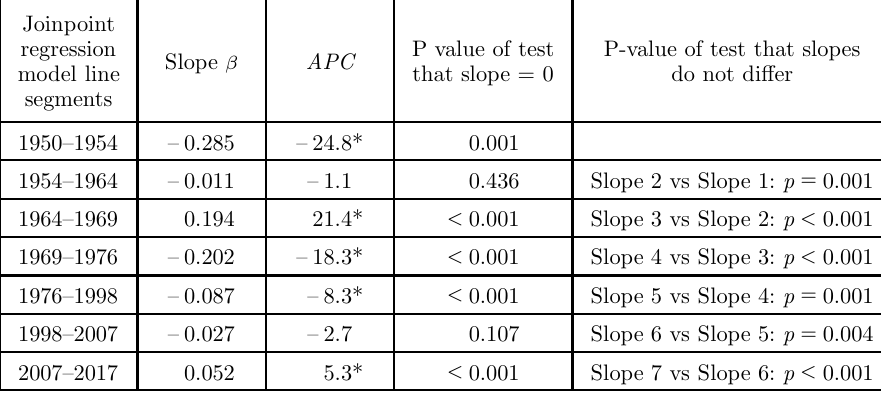
Table 2. Final selected model for 6 joinpoints Joinpoint